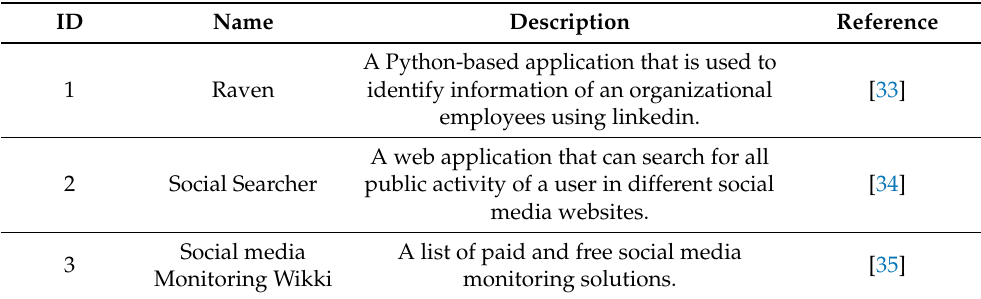
Table 4. Tools used for OSINT on social